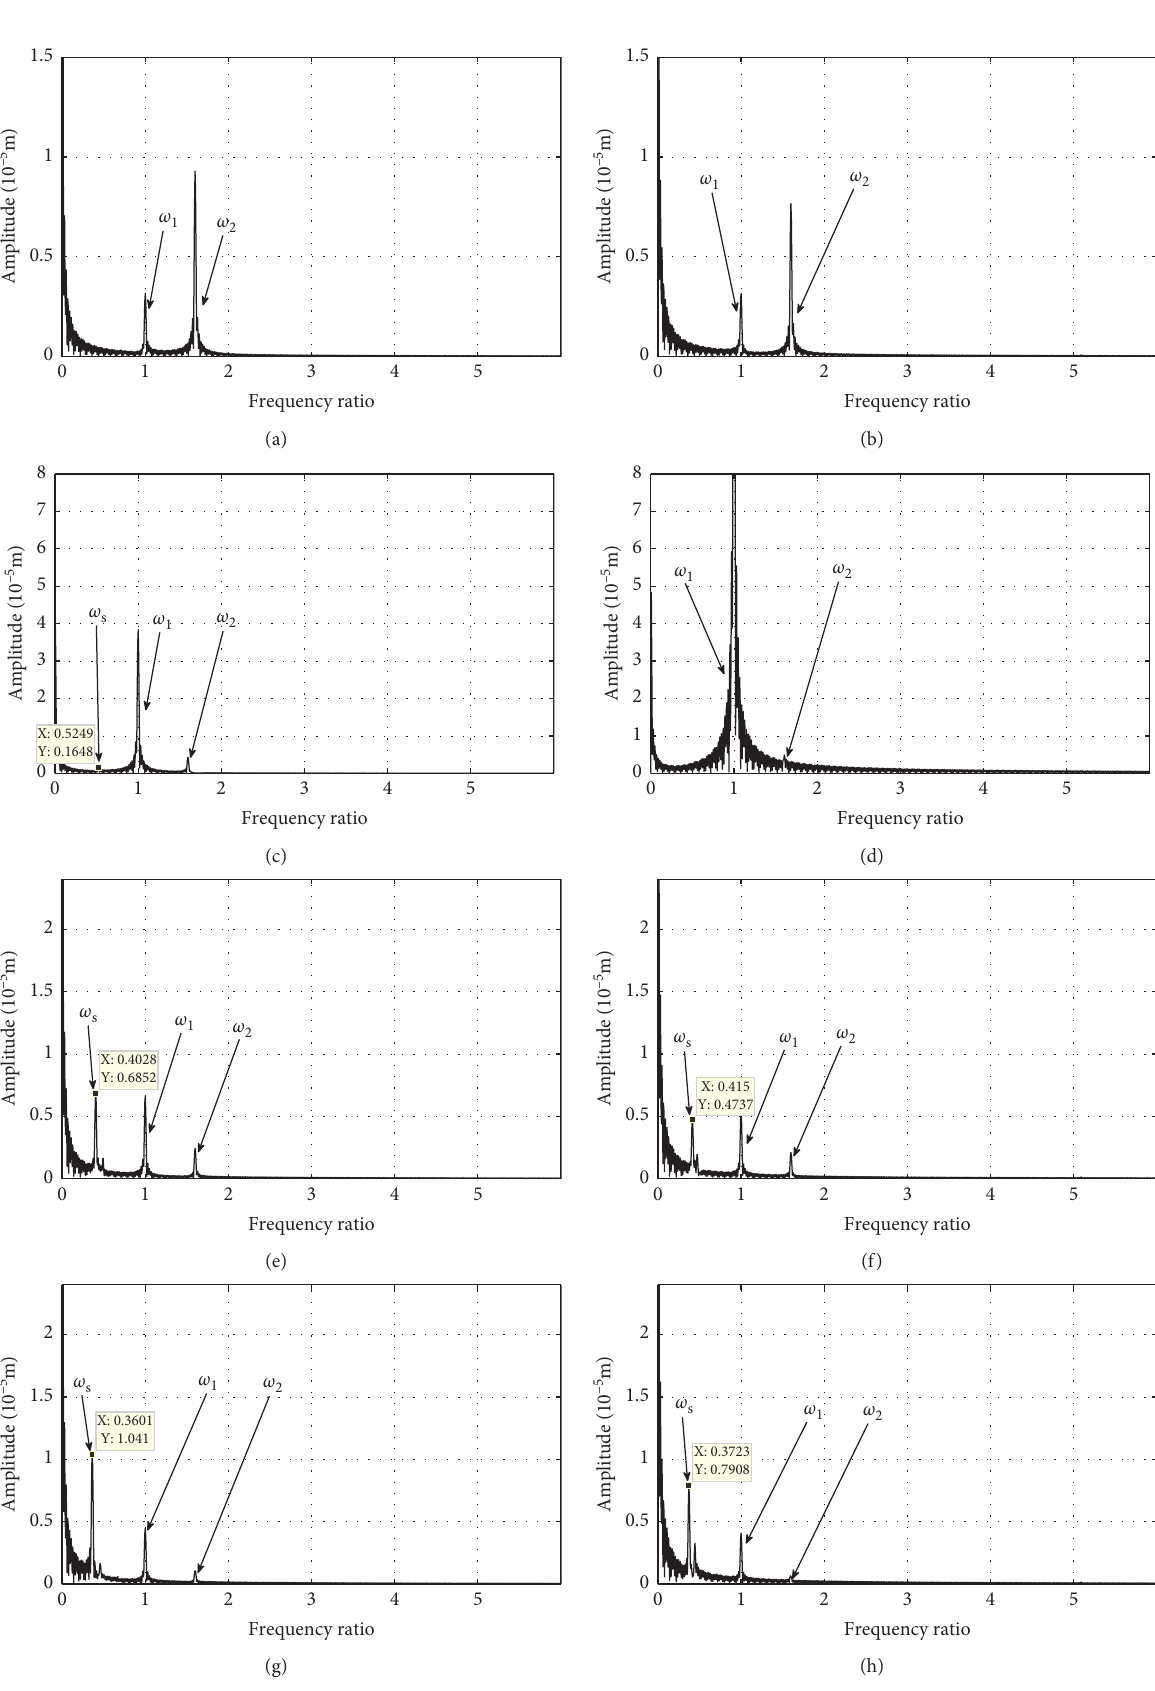
Figure 21: Spectrograms for the vertical vibration of disk 3. (a) 300rad/s, λ � 1 . 6. (b) 300 rad/s, λ � − 1 . 6. (c) 400rad/s, λ � 1 . 6. (d) 400rad/s, λ � − 1 . 6. (e) 500rad/s, λ � 1 . 6. (f) 500rad/s, λ � − 1 . 6. (g) 550rad/s, λ � 1 . 6. (h) 550rad/s, λ � − 1 .